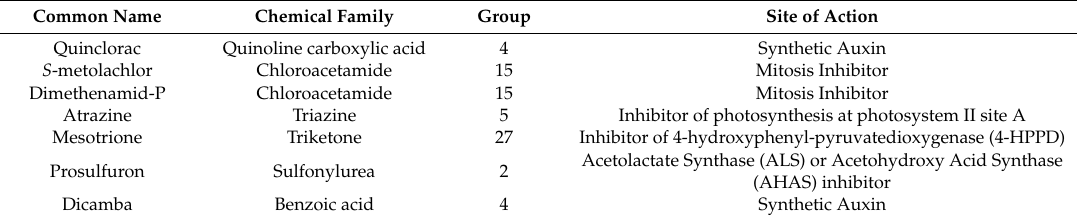
Table 4. Herbicide site of action (SOA) classification for herbicides used in this study.